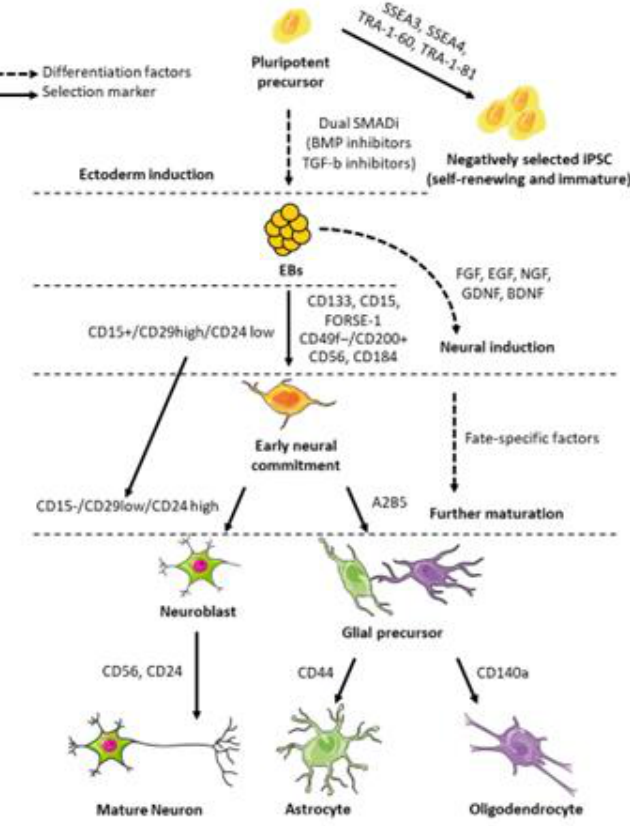
Figure 2. Neural stem cell differentiation pathways and lineage-specific markers. Diagram shows the differentiation stages and defined markers for isolation of NSCs, neurons and glia derived from pluripotent stem cells.